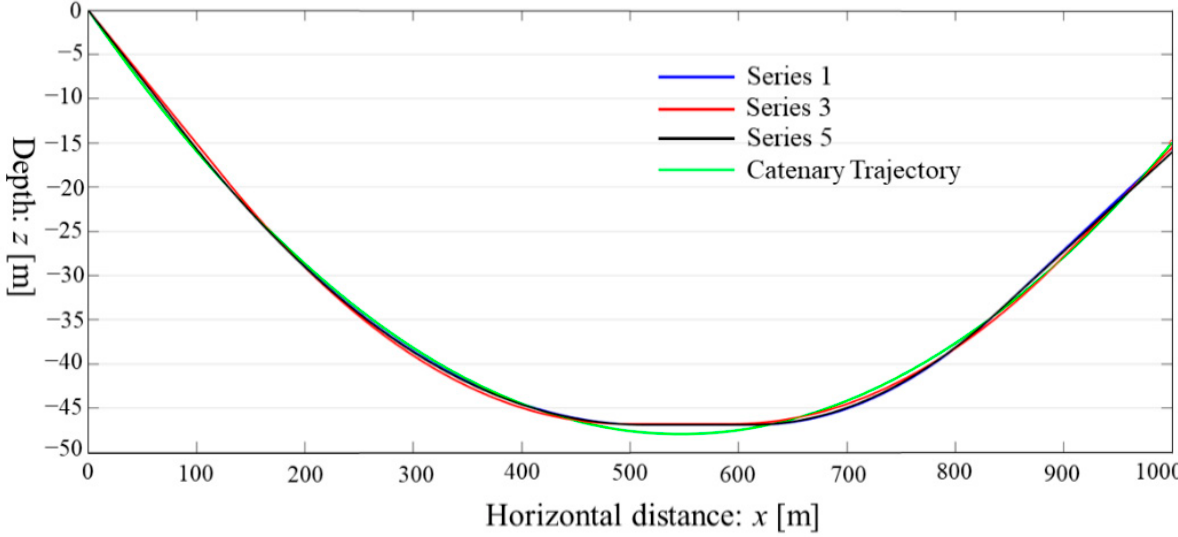
Figure 6. Solutions of fittings: Series 1, 3, and 5.